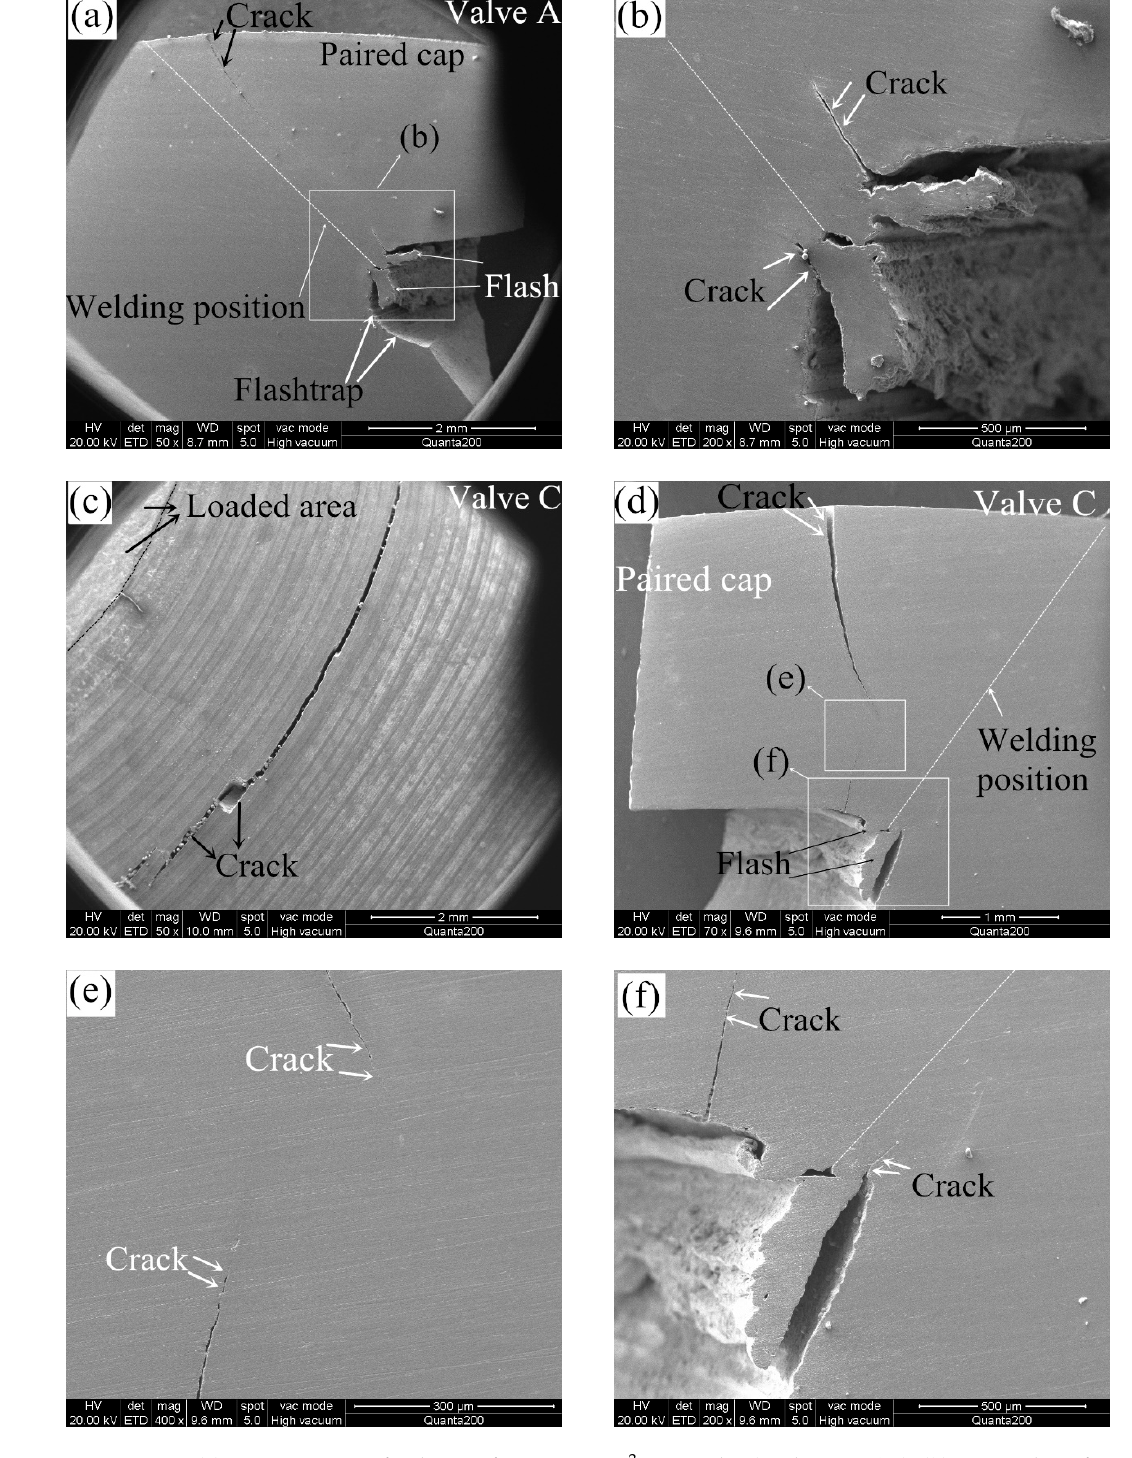
Figure 17. ( a ) Cross-section of valve A after 9300 × 10 3 test cycles (4.2 kN, 650 ◦ C); ( b ) inner edge of cross-section of valve A; ( c ) combustion face of valve C after 2400 × 10 3 test cycles (8.0 kN, 400 ◦ C); ( d ) cross-section of valve C; ( e ) enlarged view of cracks on cross-section of valve C; ( f ) inner edge of cross-section of valve C.